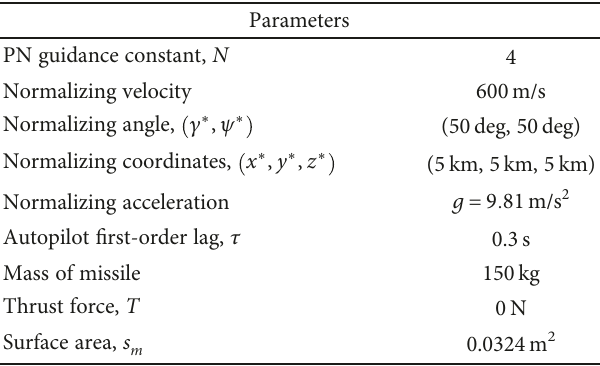
Table 1: Simulation